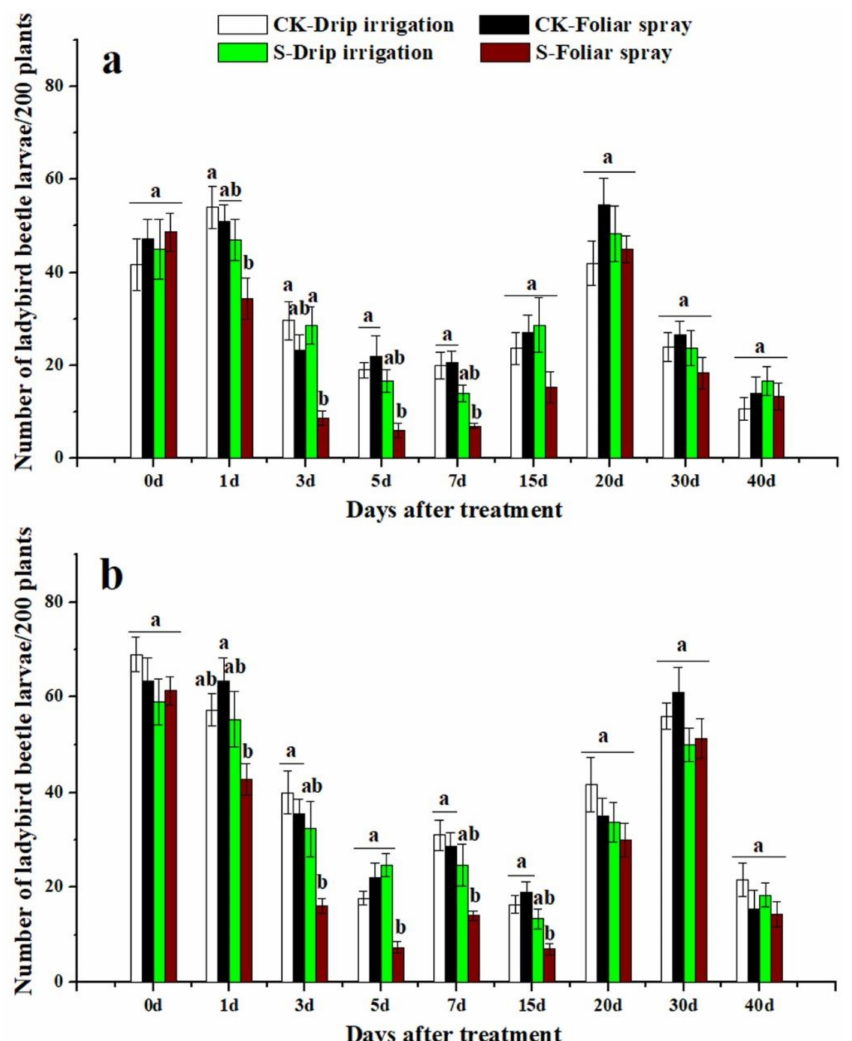
Figure 4. The numbers of ladybird beetle larvae on cotton plants not treated with any chemical (CK-Drip irrigation and CK-Foliar spray) and treated with sulfoxaflor through drip irrigation (S-Drip irrigation) and foliar spray (S-Foliar spray) in 2016 ( a ) and 2017 ( b ). All data are expressed as mean ± S.E. (n = 3). Values within the same time period labeled with di ff erent letters are significantly di ff erent based on Tukey’s HSD test at p <